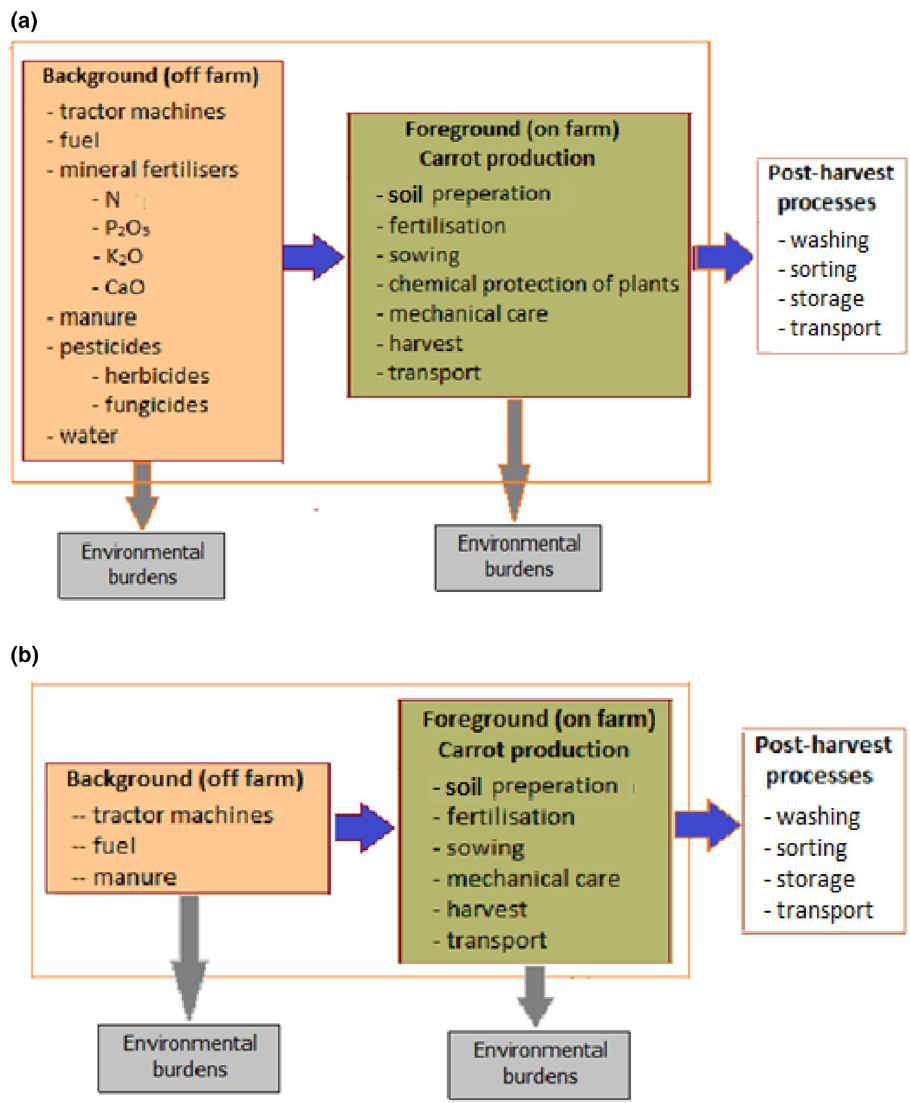
Figure 1. System boundaries: ( a ) conventional production of carrot, ( b ) organic production of